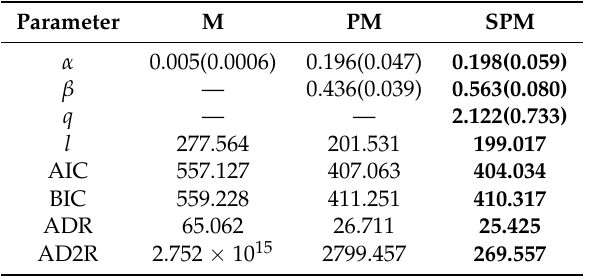
Table 7. ML estimates for the charities data with standard deviations in parentheses.